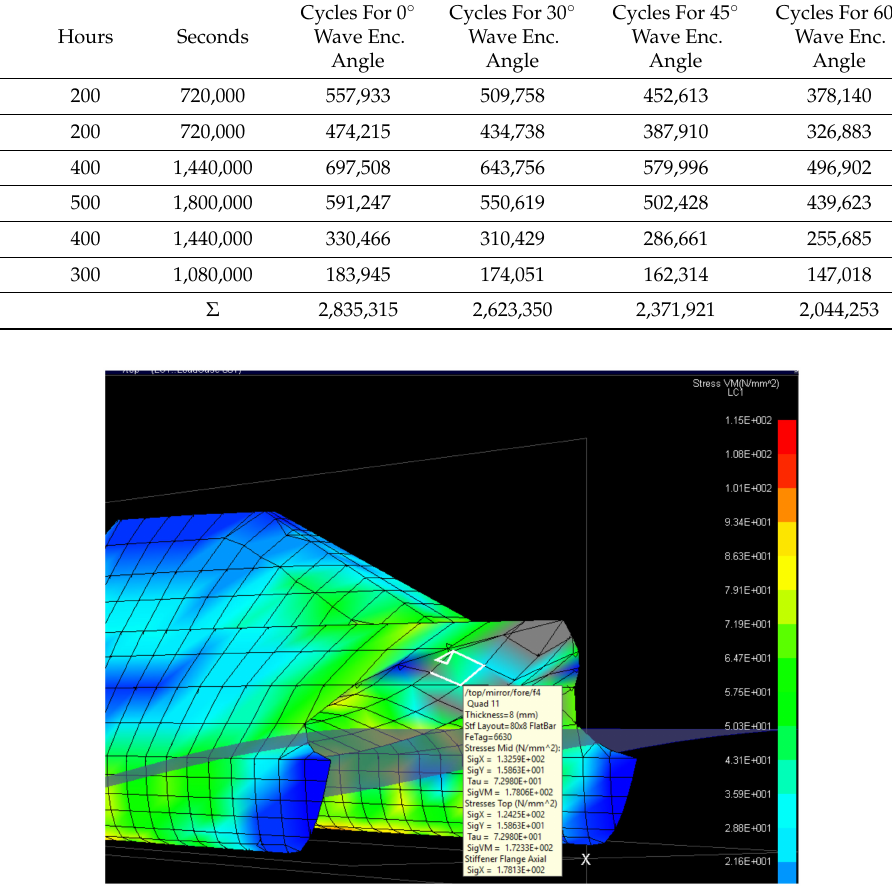
Figure 7. Stress values for LS2 loading